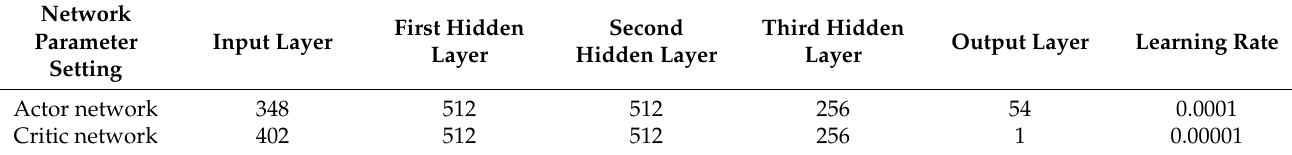
Table 1. Neural network structure and